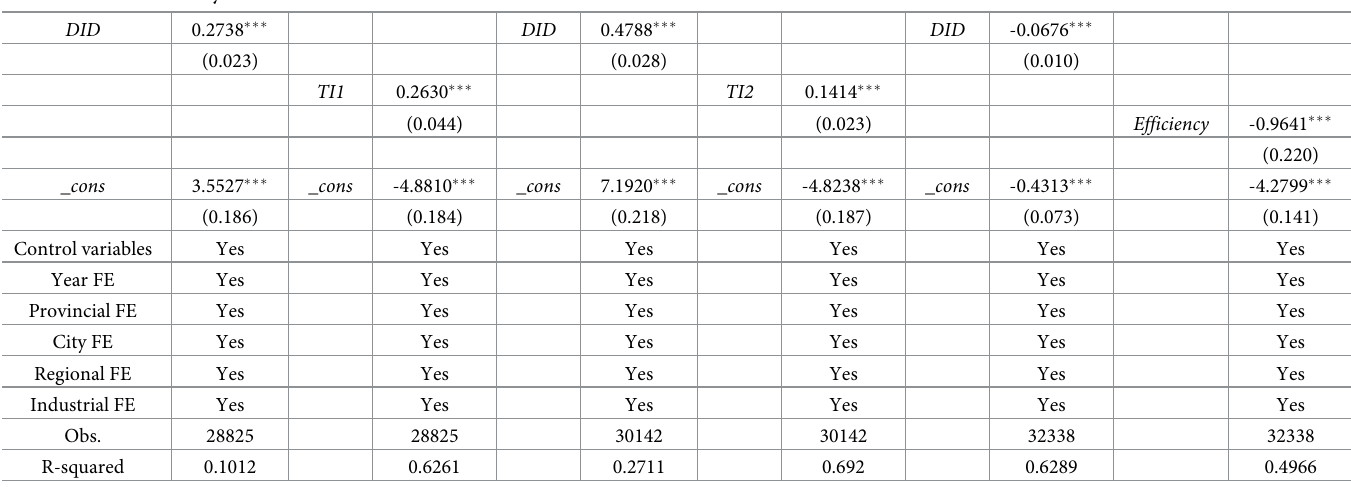
Table 6. Mechanism